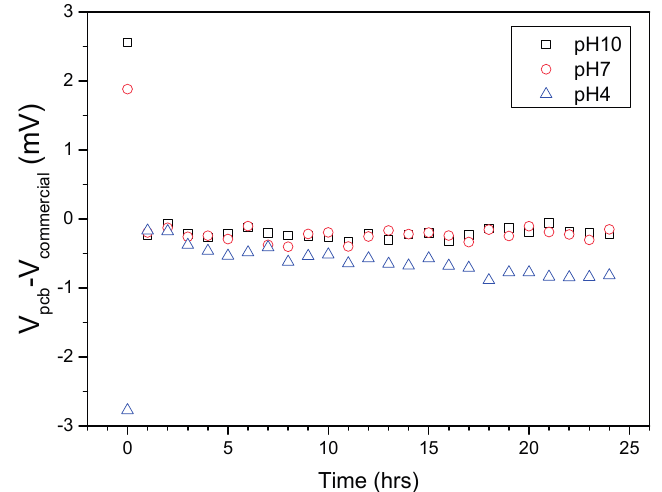
Figure 5. Voltage difference between PCB (Printed Circuit Board) pseudo-reference electrodes and commercial Ag/AgCl reference electrodes V pcb -V commercial evolution with time at different pH values.